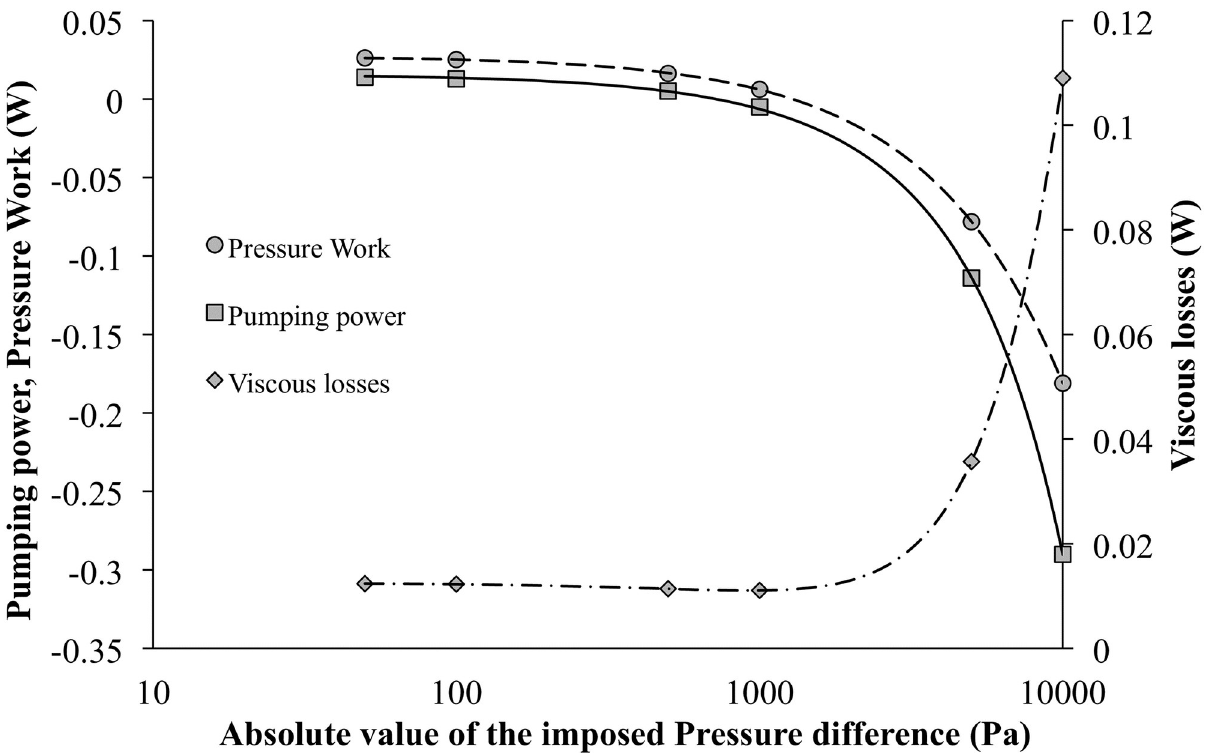
Fig 8. Performances of the dynamic corrugated heat exchanger. Pumping power, pressure work and viscous loss for corrugated moving channel as a function of the imposed negative pressure differences for relative amplitude of A = 89% and f r = 50 Hz .